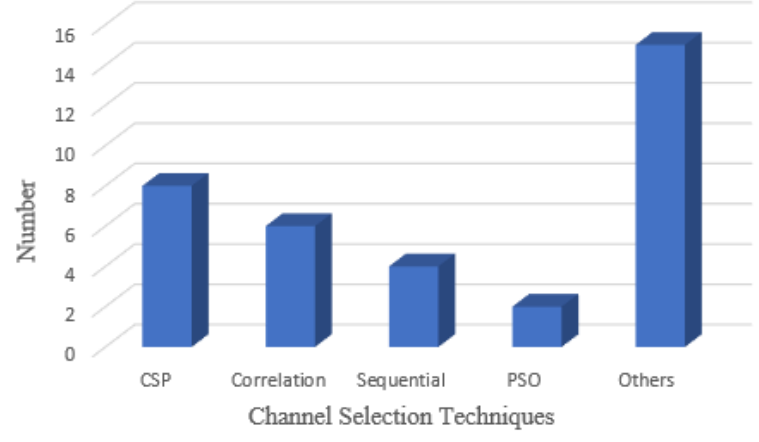
Figure 16. Number of different